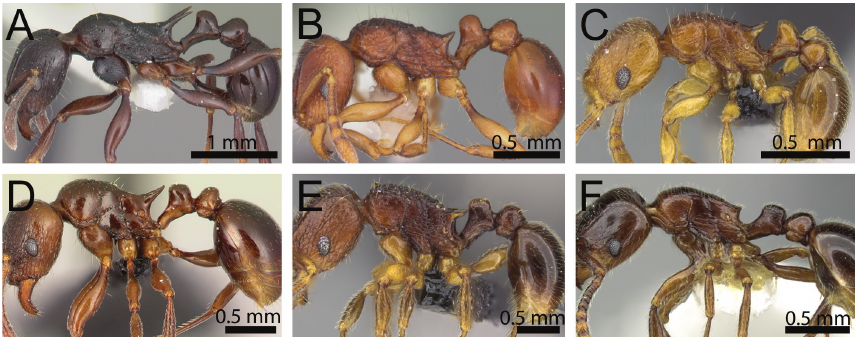
Figure 13. Body in profile. A T. severini (CASENT0102397) B T. proximum (CASENT0102342) C T. rumo (CASENT0073025) D T. malagasy (CASENT0449550) E T. dalek (CASENT0038402) F T. tyrion (CASENT0249085).